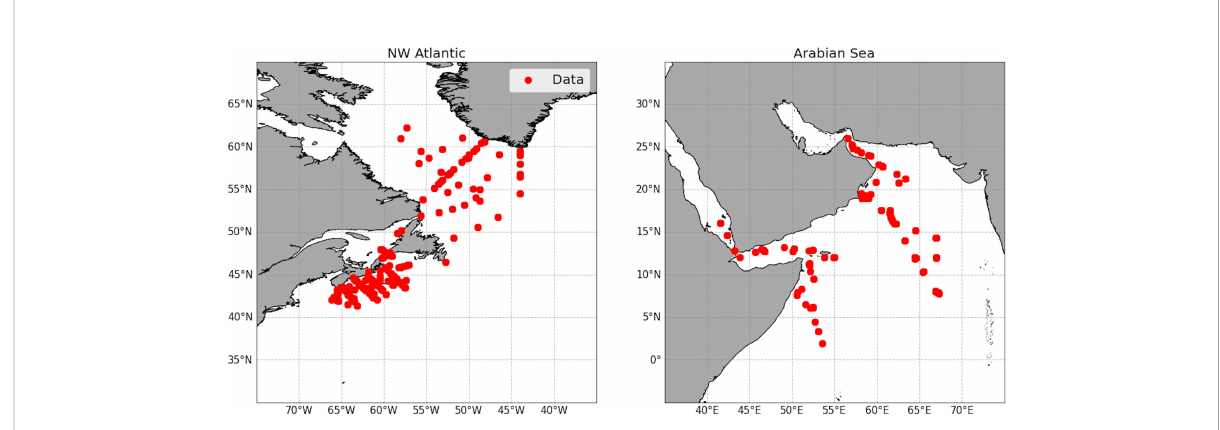
FIGURE 1 Maps of the sample collection sites for both the northwest Atlantic and the Arabian sea. Red dots indicate where the carbon and nitrogen data were located.